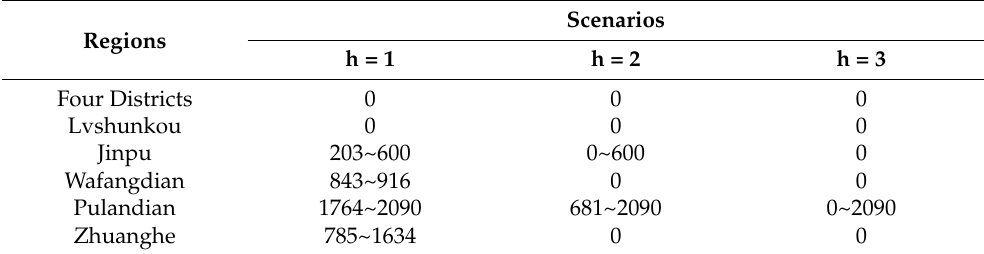
Table 9. Upper and lower bounds of water resource deficit for ecological environment sector under different scenarios in period